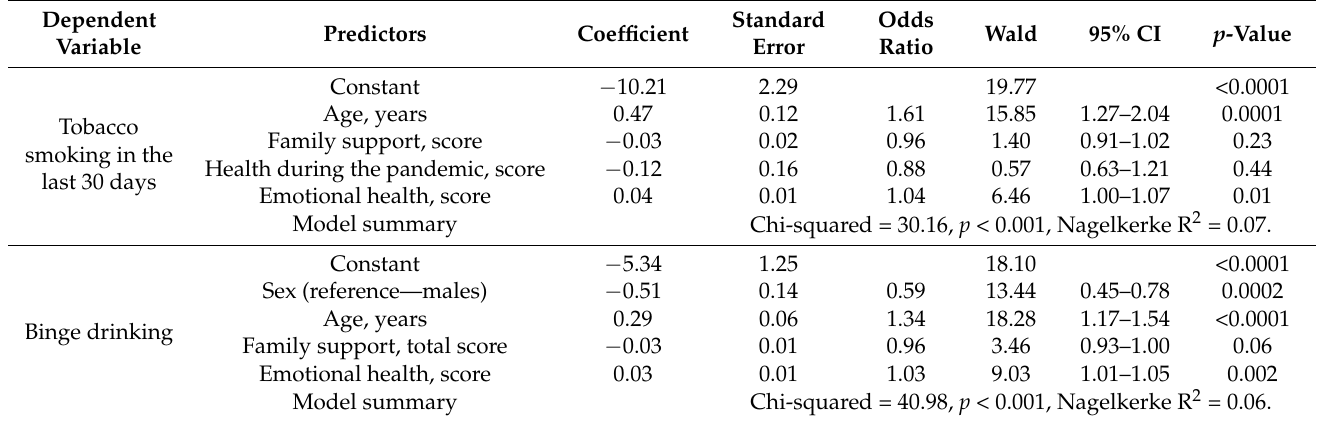
Table 6. Summary of multiple binary logistic regression analysis for predicting risky